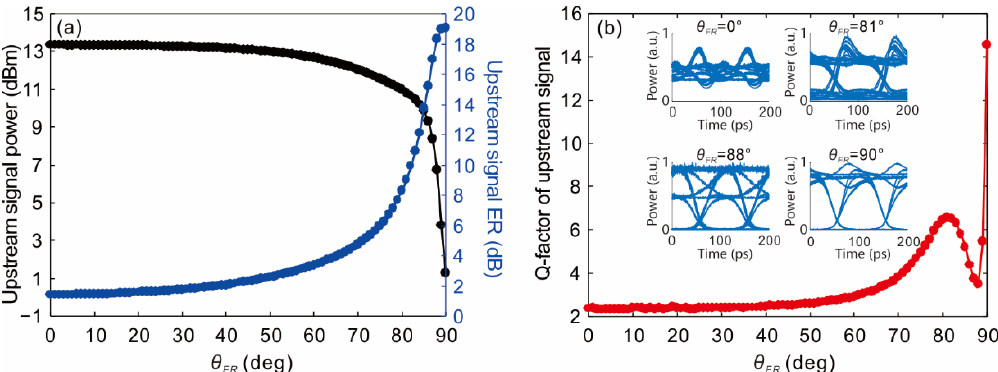
Figure 4. Faraday rotation angle dependence of the ( a ) upstream signal power and dynamic ER, and Q-factor. Inlets are the 10 Gbps upstream signal eye-diagrams at di ff erent Faraday rotation angles. ( b ) Q-factor. Inlets are the 10 Gbps upstream signal eye-diagrams at different Faraday rotation angles. (downstream signal power at input: − 10 dBm, ER: 6 dB, wavelength: 1550 nm; SOA DC bias current: (downstream signal power at input: −10 dBm, ER: 6 dB, wavelength: 1550 nm; SOA DC bias current: 150 mA; EAM bias voltage: − 1 V, EAM peak-peak voltage: 2 150 mA; EAM bias voltage: −1 V, EAM peak-peak voltage: 2 V).